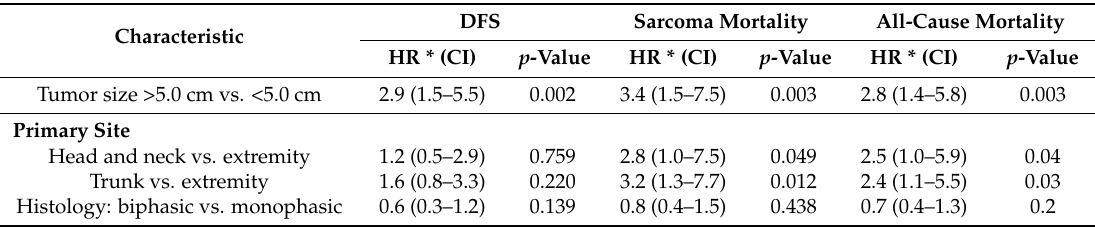
Table 3. Impact of tumor size, primary site, and histology on disease-free survival (DFS), sarcoma-specific mortality, and all-cause mortality for patients with early-stage synovial sarcoma.